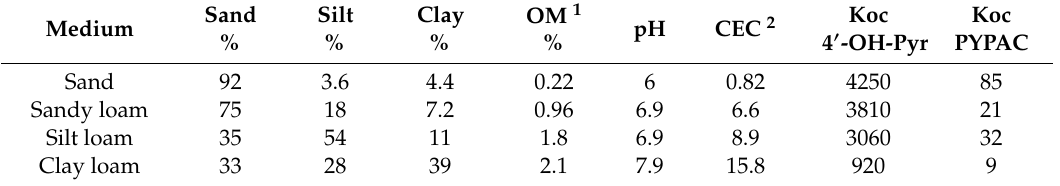
Table 4. Koc values of 4 (cid:48) -OH-Pyr and PYPAC in di ff erent soils and sand (adapted from